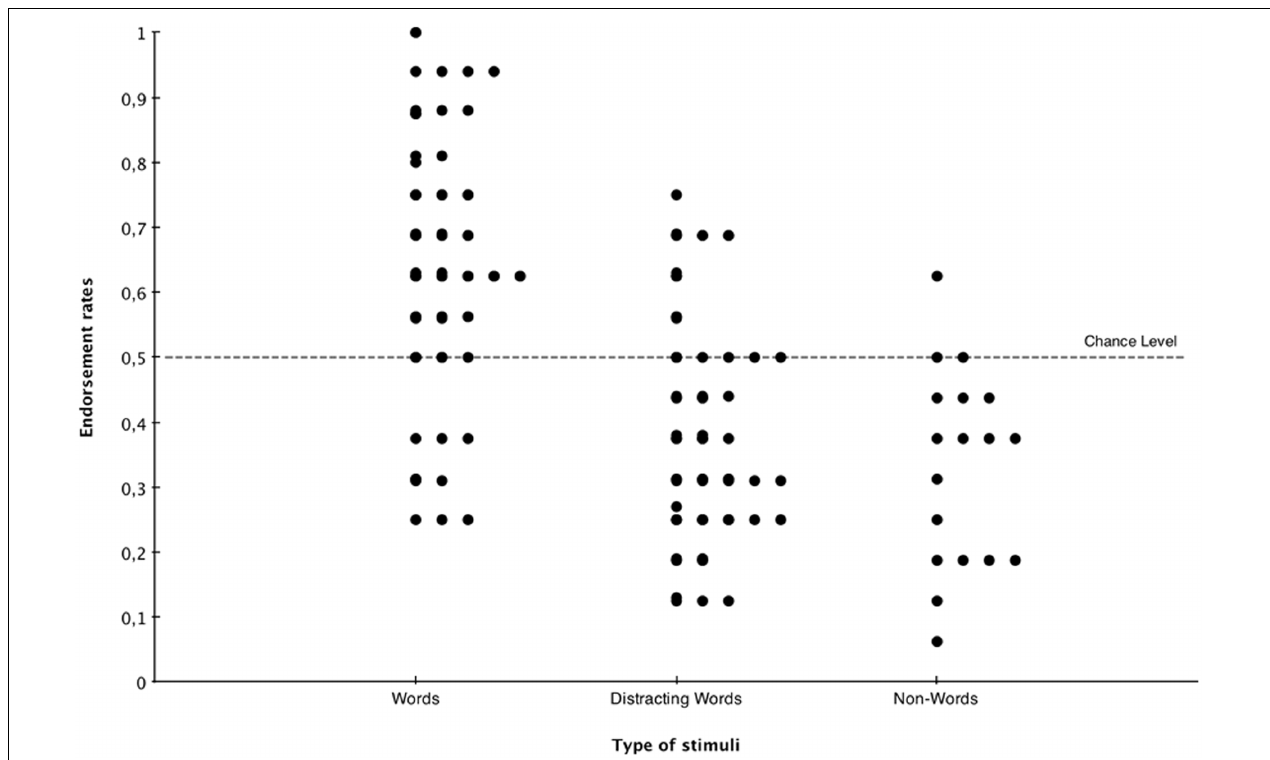
FIGURE 5 | Endorsement rates for target words, distracting words, and for non-words in the exclusion